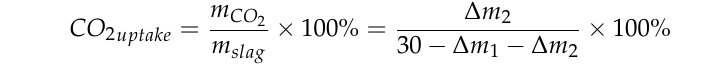
the pH value of leaching